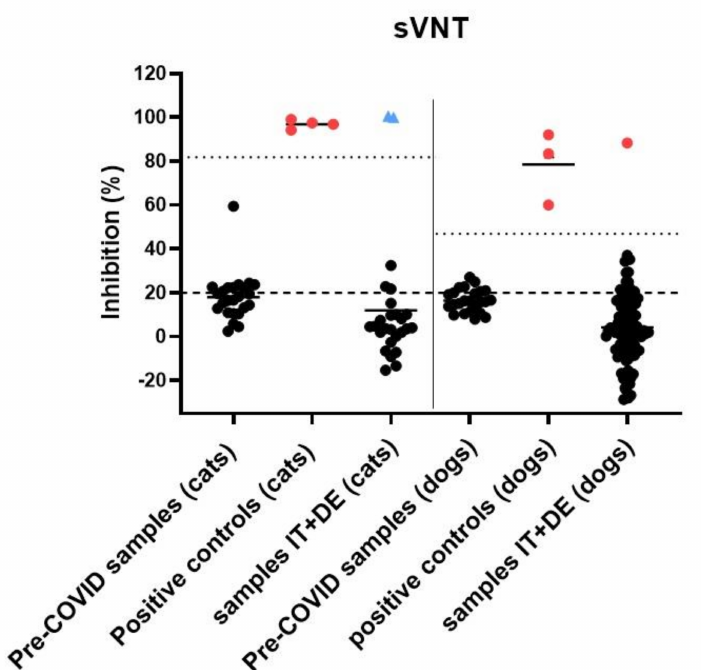
Figure 5. Surrogate virus neutralization test (sVNT) results on cat sera (left) and dog sera (right). The calculated inhibition is indicated as a percentage on the y -axis. The dotted lines show the positive cut-off value set for cat and dog samples, by calculating the six-fold standard deviation above the mean of pre-COVID-19 controls inhibition (81.8% in cats and 47% in dogs). The dashed line indicates the positive cut-off set, according to the manufacturer’s instructions, at 20%. Positive samples, which were also confirmed by the University of Utrecht, are shown as red dots. One dog (ID 5) showed neutralizing activity with an inhibition of 88.3%. The two samples collected from the RT-qPCR-positive cat (ID 234) in October 2020 with an inhibition of 99.9% and in November 2020 with an inhibition of 100.5% are indicated with blue